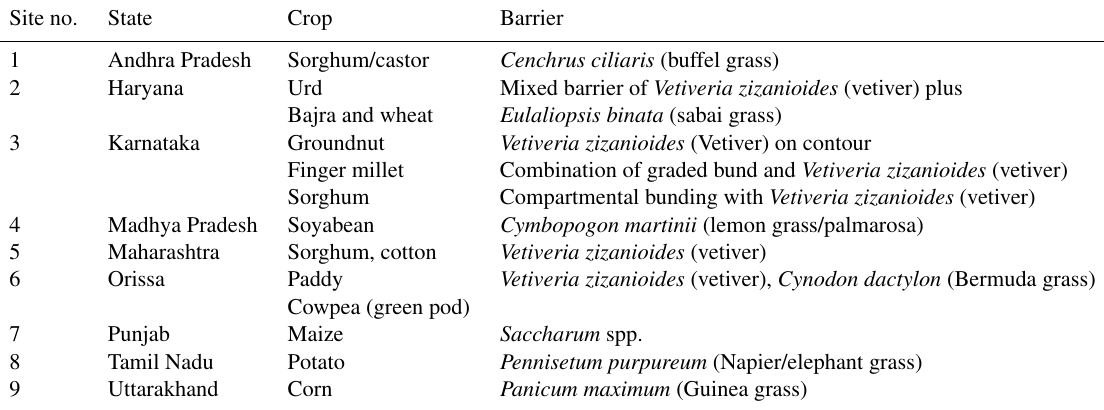
Table 4. Site-specific suitable grasses for contour grass barrier (CGBs). Site